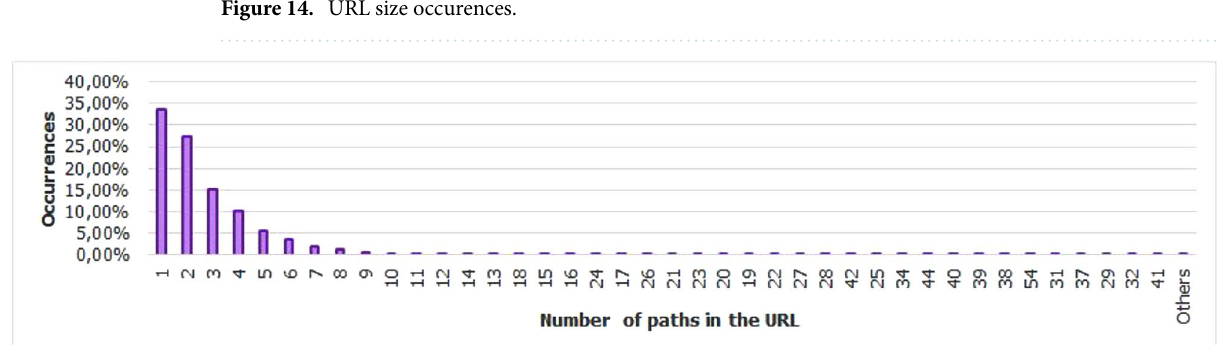
Figure 15. Number of paths